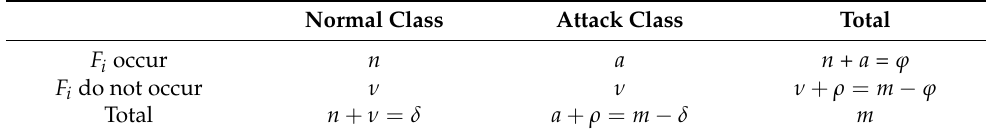
Table 4. Computation of chi-square test